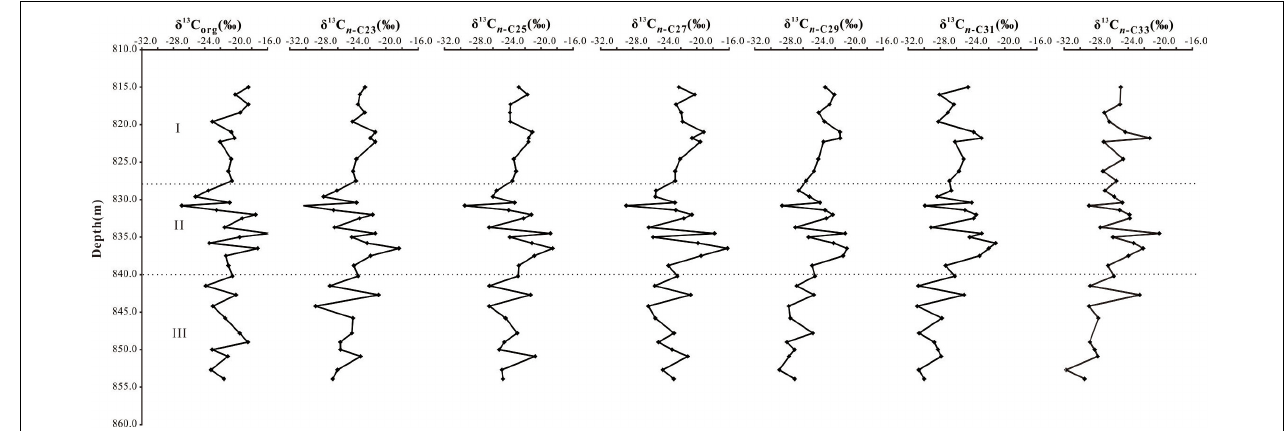
FIGURE 7 | The profile variation of δ 13 C composition of the bulk organic matter and individual n -alkane compounds.